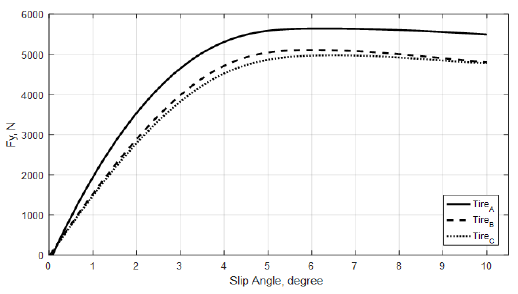
Figure 10. Lateral tires’ force test results.